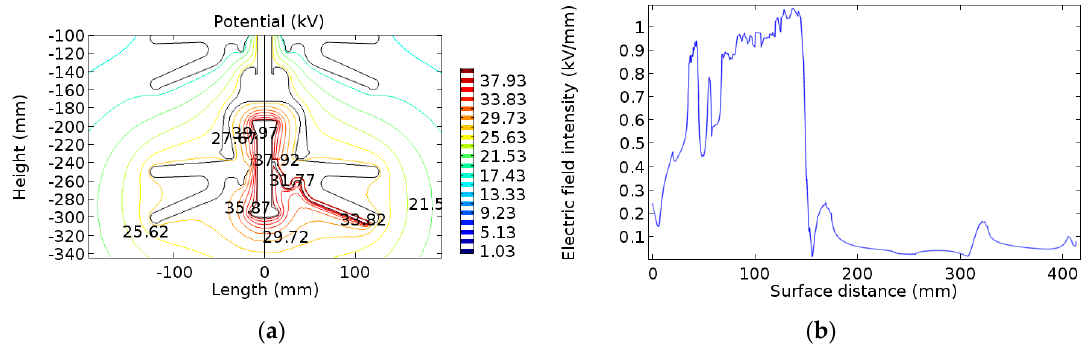
Figure 19. Simulation results of Extension 4: ( a ) equipotential line distribution; ( b ) electric field distribution along No. 1 insulator.